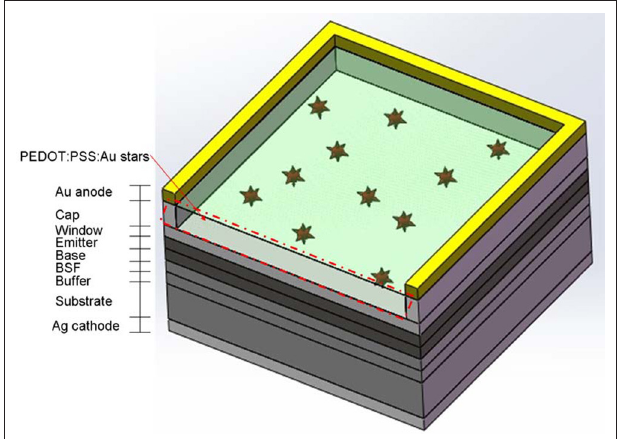
FIGURE 1 | Scheme of plasmonic GaAs solar cell with the PEDOT:PSS film decorated with Au NSs.